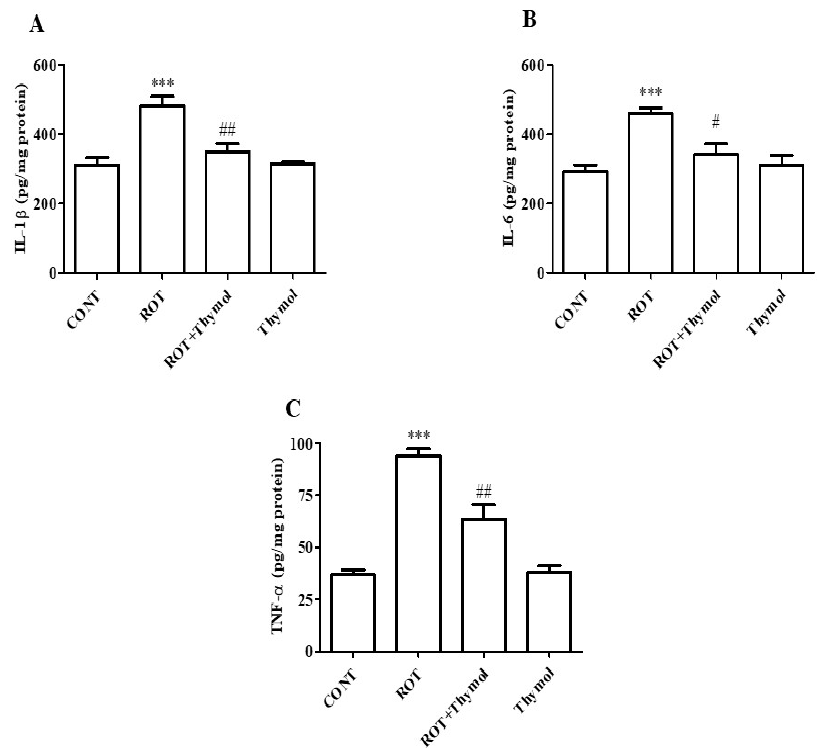
Figure 5. ELISA was used to quantify the level of proinflammatory cytokines; IL-1 β , IL-6 and TNF- α in the mid brain tissues of rats from different experimental groups. The levels of IL-1 β ( A ), IL-6 ( B ) and TNF- α ( C ) were significantly (*** p < 0.001) enhanced in ROT challenged rats when compared to CONT group rats. Thymol treatment to ROT challenged rats showed a significant (## p < 0.01; # p < 0.05) decrease in the levels of ROT-induced rise of proinflammatory cytokines. Additionally, the cytokines levels did no show significant difference in the rats of CONT and thymol alone groups. The values are presented as mean ± SEM ( n = 6–8).